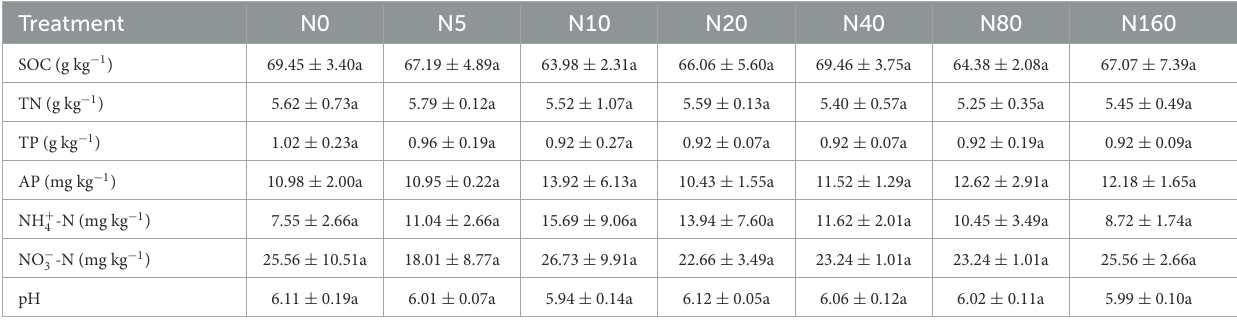
TABLE 1 Background data of soil nutrients in nitrogen addition plots.